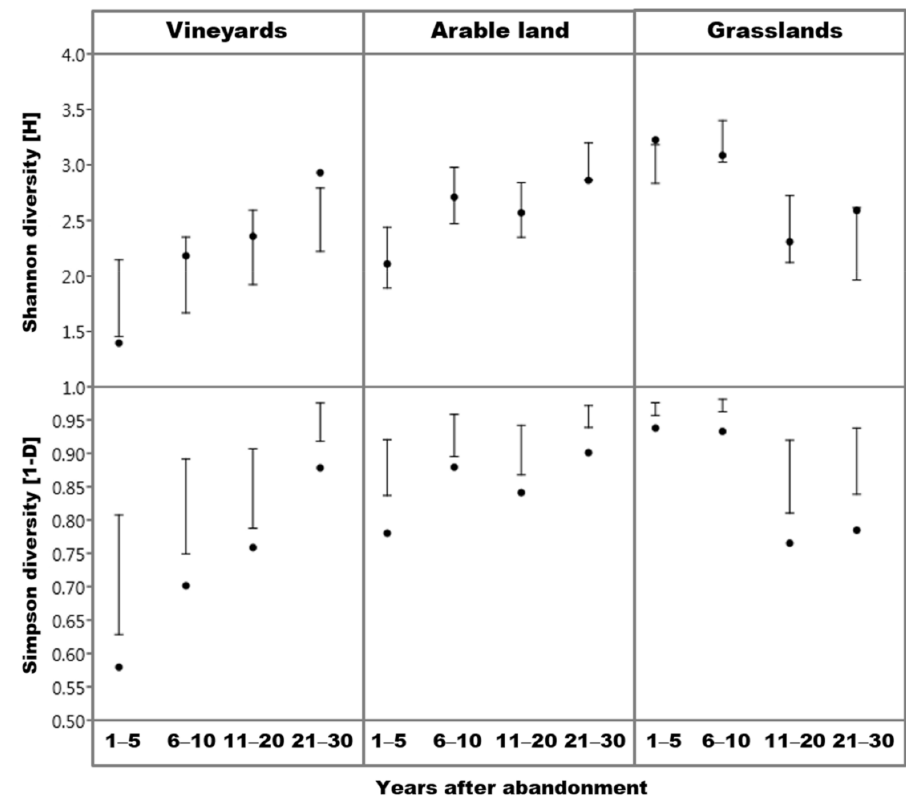
Figure 3. Changes in Shannon and Simpson diversity values in age groups of abandoned lands (PAST 4.08 uses 1-D formula for Simpson index [86]). Table 2. Statistical results of the diversity of abandoned land types for the studied age groups. Diversity Permutation Test Results—Perm p